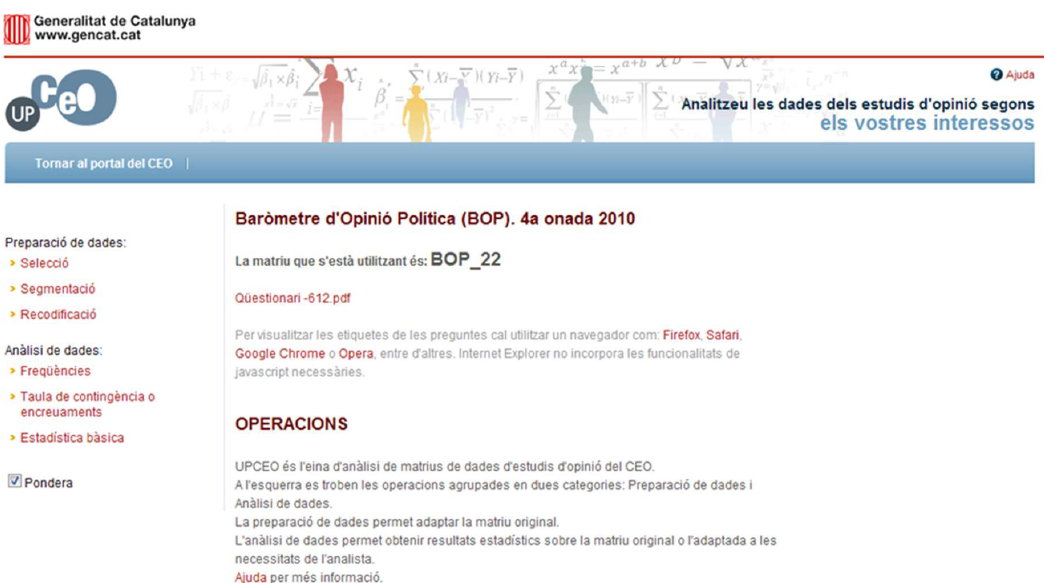
Figure 11. Once the matrix is selected, the user can perform some operations to the data. In the figure, the operations that can be performed over the selected matrix of data (the Baròmetre d’Opinió Política of 2010), are shown on the left side.